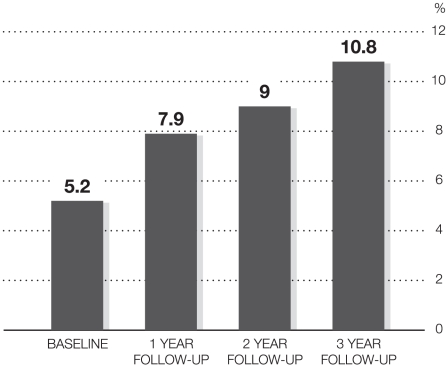
Percentage of respondents rating their sleep quality as pretty poor or poor.